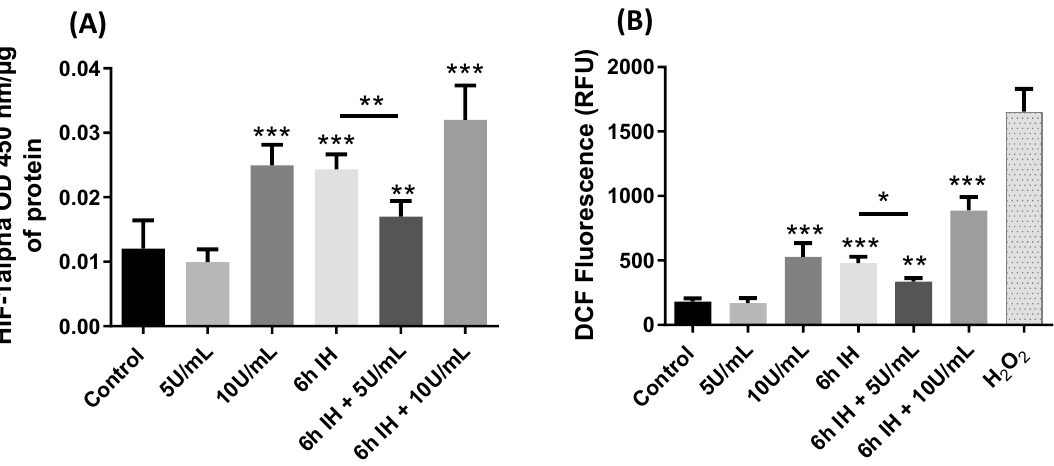
Figure 3. Expressions of HIF-1α ( a ) and ROS production ( b ) in our different conditions. For treatment with thrombin, cells were exposed to thrombin at 5 or 10 U/mL for 1 h. Then cells were also exposed to 6 h of IH alone or associated with thrombin at 5 or 10 U/mL during the last hour. Values are presented as mean value ± SD ( n = 9, N = 3), * p ≤ 0.05, ** p ≤ 0.01, *** p ≤ 0.001 compared to control condition. IH: intermittent hypoxia, ROS: reactive oxygen species, HIF-1α: hypoxia-inducible factor 1 alpha, DCF: